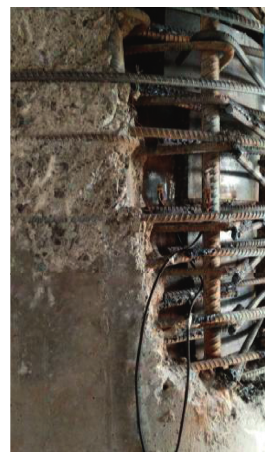
Figure 17: Actual arrangements of strain measuring points 31 and 34.